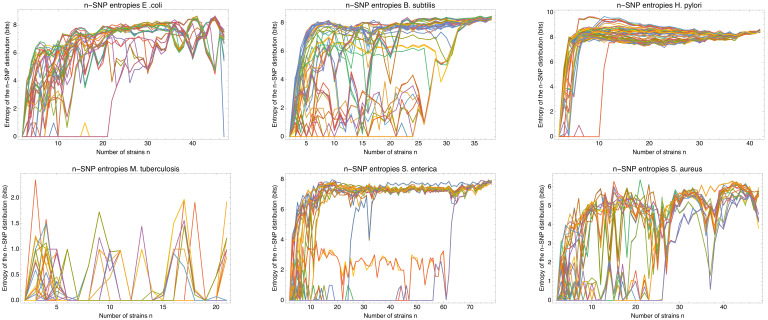
Entropy profiles of all the strains for each of the six species. Each panel corresponds to one species (indicated at the top) and shows the entropy profiles Hs⁢(n) of the distributions of n-SNPs in which a particular strain s occurs as a function of the number of strains n (different colors).